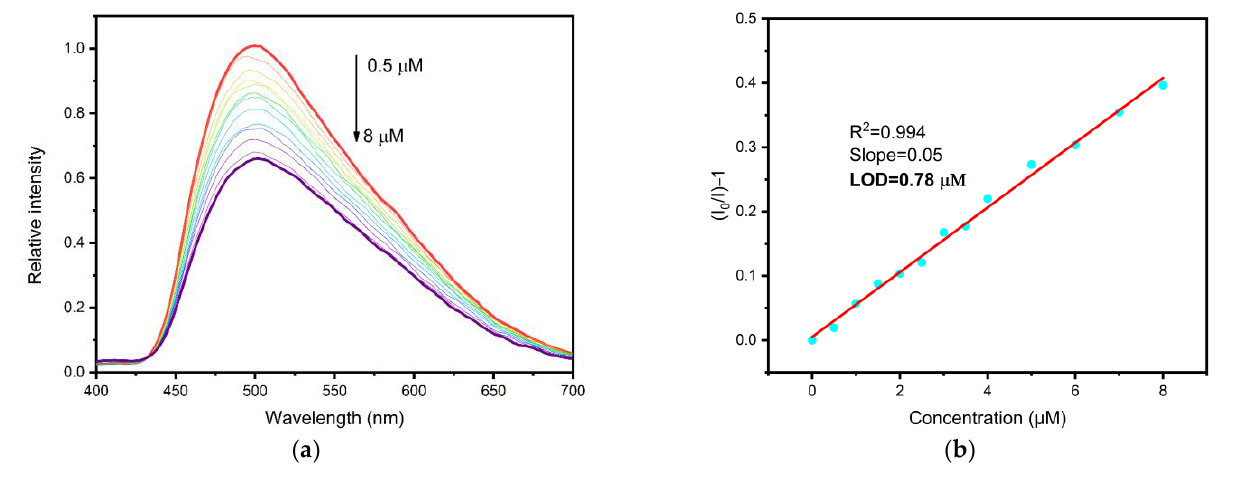
Figure 7. Fluorometric titration of gossypol: ( a ) Emission spectra of MOF 1 ethanol suspension at 310 nm excitation, with different amounts of gossypol added and the cottonseed oil as background; ( b ) Linear approximation of luminescence quenching for LOD calculation. The relative luminescence quenching values were calculated from the integral intensities.